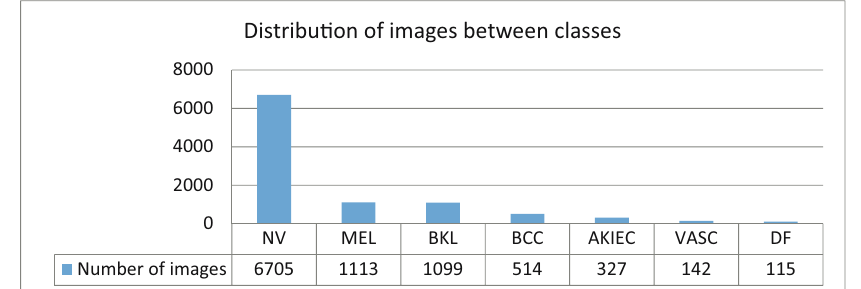
Figure 6: Distribution images of HAM10000 between